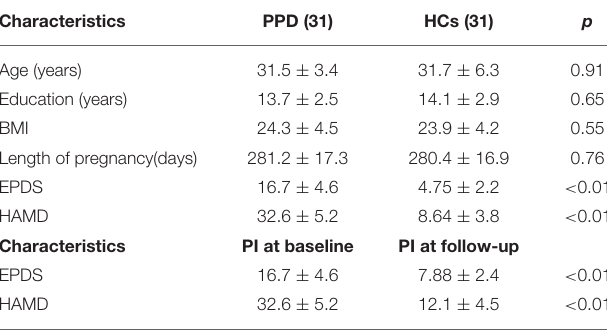
TABLE 1 | Demographic and clinical characteristics of